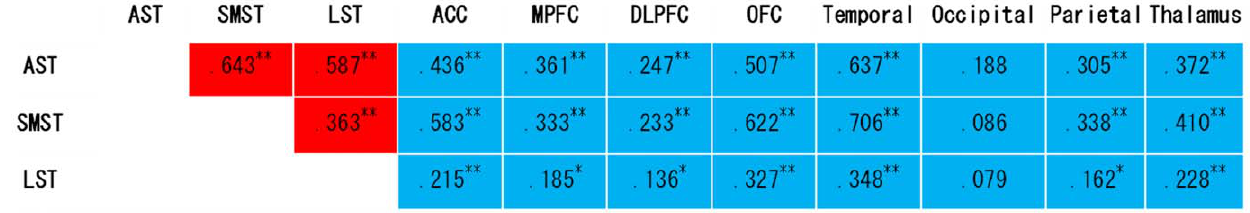
Figure 3. Correlations between striatum and extrastriatal regions and intercorrelations among striatal subdivisions in dopamine D 1 receptor BP ND . **P , 0.01, *P , 0.05. Correlations in red: intercorrelations among striatal subdivisions. Correlations in blue: correlations between striatal subdivisions and extrastriatal regions. R 2 values are presented for the correlations.